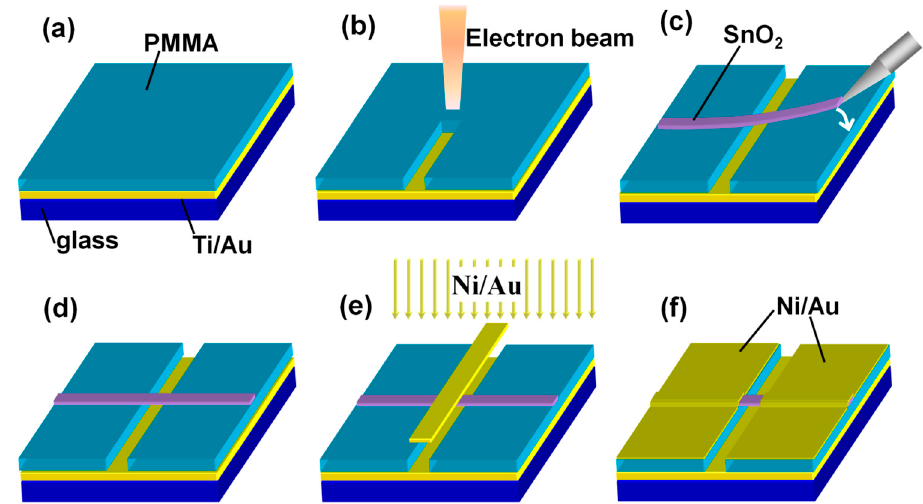
Figure 1. The schematic representation for the fabrication of the gas-dielectric SnO 2 nanobelt field-effect transistor (FET).